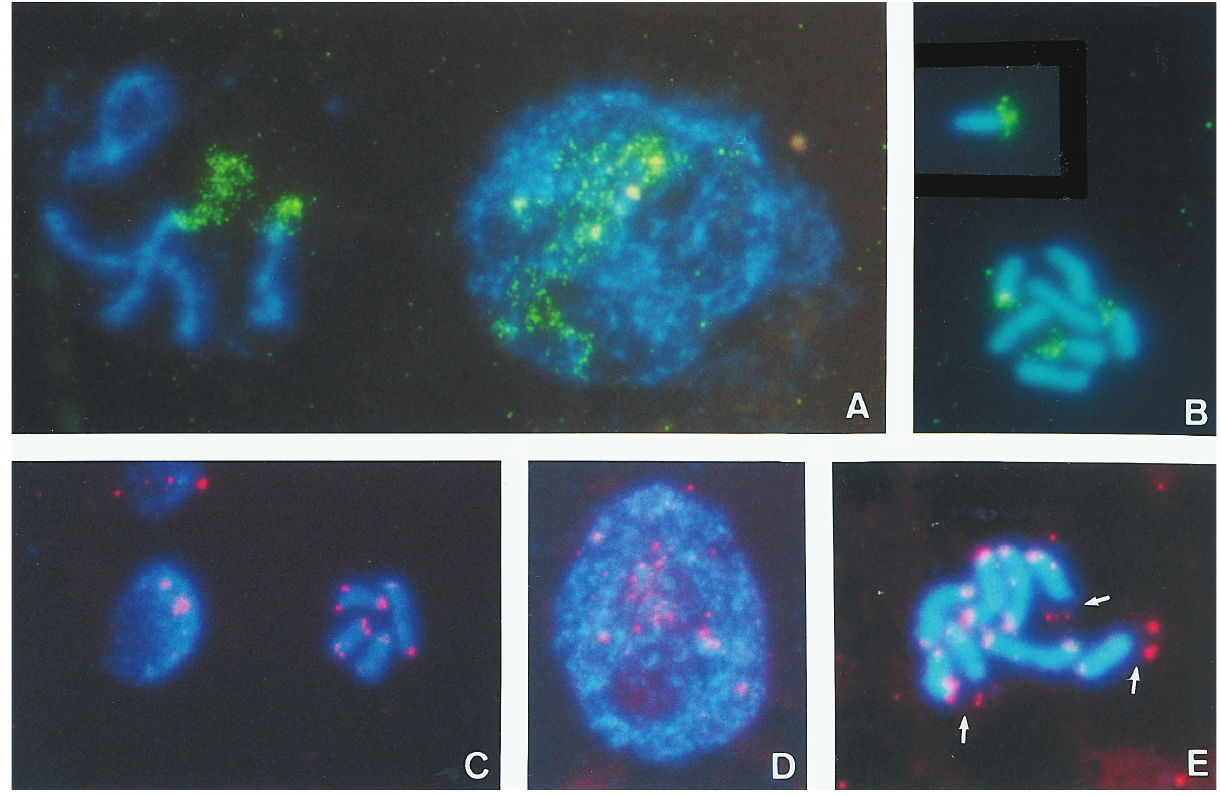
Figure 1 - FISH with probes of 45S rDNA and telomere in Rhynchospora tenuis chromosomes. A) Nuclei and prometaphase of 2n = 4 race hybridized with45SrDNA.B)Metaphaseof2n=8racehybridizedwith45SrDNA.Observethediffusedstateofhybridizationsignals(FITC)onthechromosomes. Chromosome inside box corresponds to distant chromosome and that was a replacement of the original complement. C) Nuclei and metaphase of 2n = 4 race hybridized with telomeric probe (rodamine). D) Interphase nuclei of 2n = 8 race hybridized with telomeric probe. Observe the dispersed red signals. E) Metaphase of 2n = 8 race metaphase hybridized with telomeric probe. Arrows point to telomeric sites distant from the DAPI stained